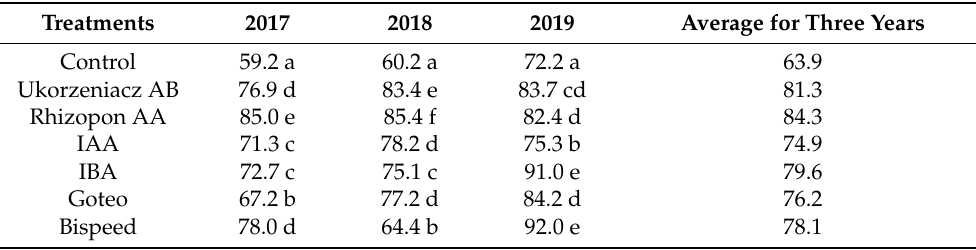
Table 2. Percentage of obtained softwood cuttings of GiSelA 5 rootstock depending on the tested treatments in the years 2017–2019.